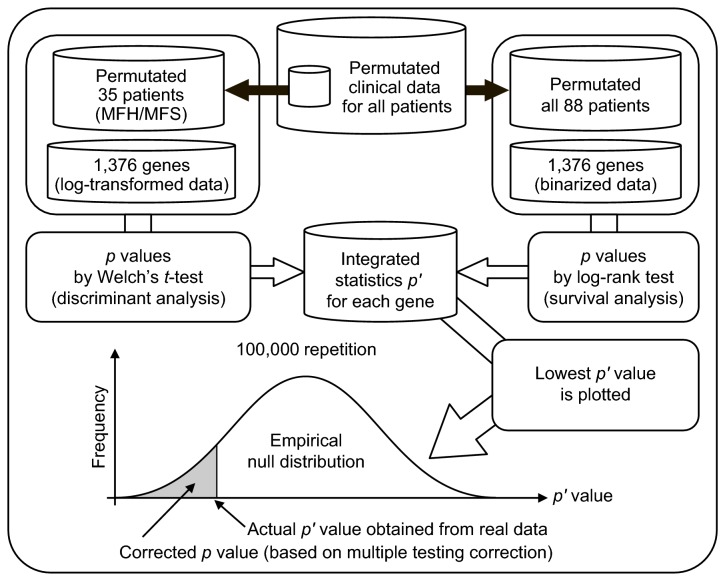
A schematic of the simulation conducted based on the permutation test.Clinical data for all patients were permutated. Permutated data for 35 STS patients (20 MFH patients and 15 MFS patients) were extracted from permutated data for all patients. For these data, p values (p
1) were calculated by applying Welch's t-test to the log-transformed gene expression data to discriminate between MFH and MFS. Otherwise, permutated data for 88 patients were used for survival analysis. For these data, p values (p
2) were calculated by applying log-rank test to the binarized gene expression data to analyze the outcome in the STS patient group. The integrated statistic p' was defined as p
1 × p
2. The lowest p' value was selected for each repetition. This procedure was repeated 100,000 times, and an empirical null distribution was constructed. Using the distribution, the actual p' value obtained from real data was converted to the corrected p value (based on the correction for multiple testing).